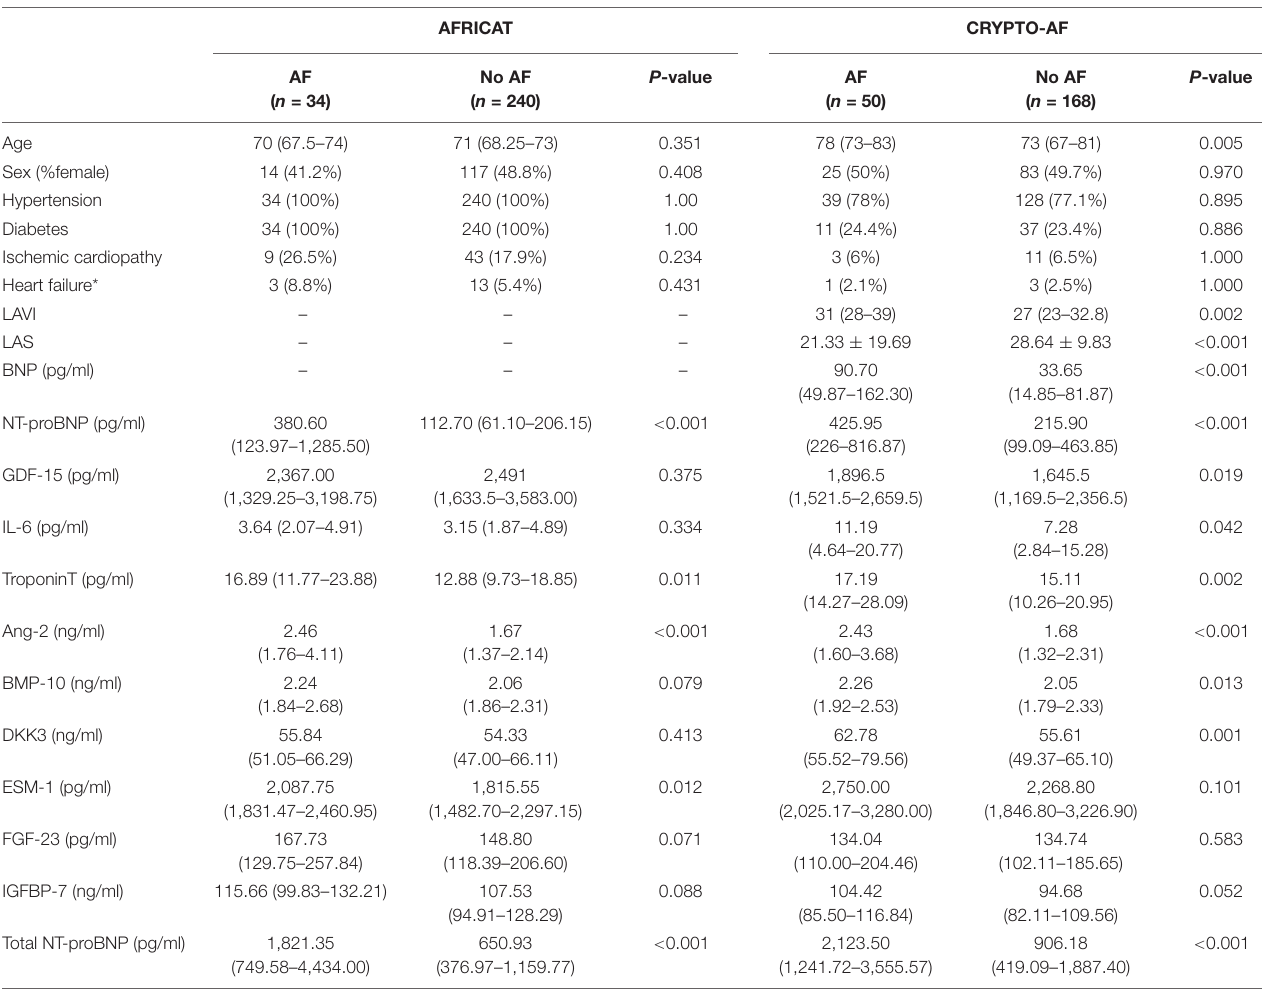
TABLE 1 | AF univariate analysis of the two included